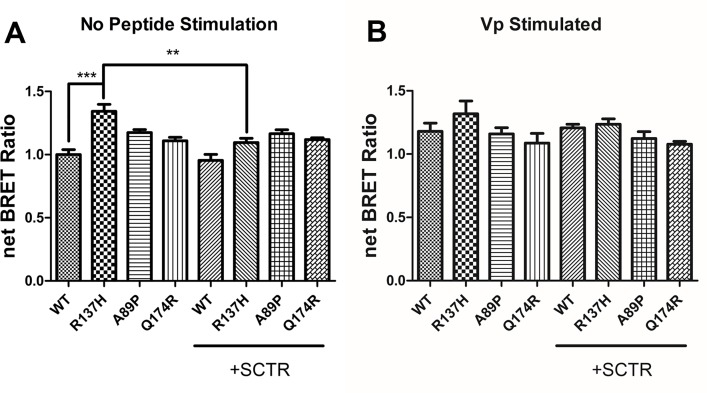
Rescue of R137H mutant by SCTR as reflected by reduced affinity to β-arrestin.The affinity between WT or mutant AVPR2 with β-arrestin were determined by BRET, using AVRP2 tagged with Rlu and β-arrestin tagged with YFP. A) In the native state, the R137H mutant shows significantly higher affinity to β-arrestin than the WT AVPR2. While the two other mutants, A89P and Q174R, showed slightly higher BRET than the WT receptor, but the increase was not significant. Upon co-expression of SCTR, β-arrestin affinity of R137H was significantly reduced compared to the scenario when no SCTR was present. B) BRET was measured at 10 min after addition of 1μM Vp to stimulate receptor internalization. WT AVPR2 showed increase affinity to β-arrestin, but not the R137H mutant without SCTR co-expression. With SCTR, R137H demonstrated increased β-arrestin binding, suggesting functional rescue of the receptor. Data are presented as means±SEM from three independent experiments in duplicate. ***, P<0.001, **, P<0.01.